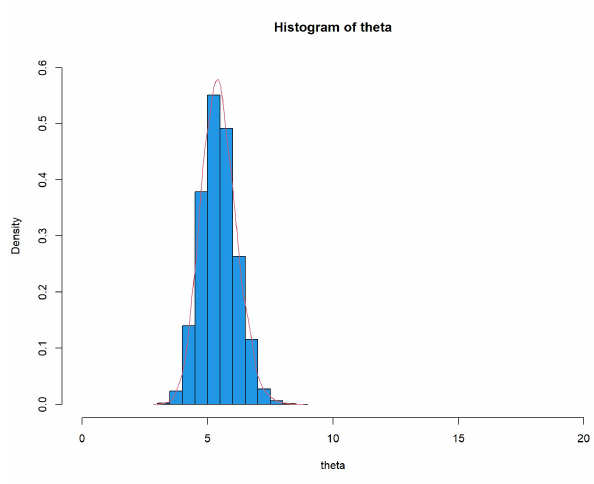
Figure 4. The sample value of theta. Red line: posterior samples of the parameter; blue histogram: posterior predictive distribution.